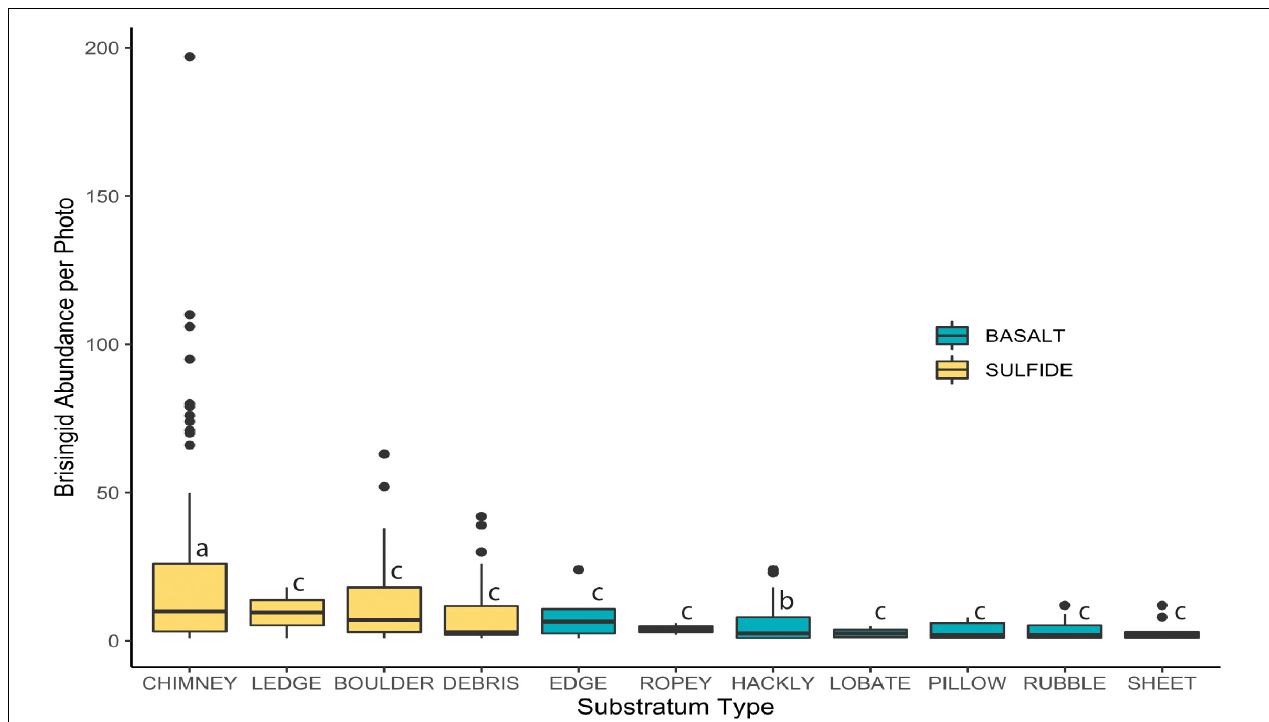
FIGURE 7 | Brisingid abundance per photo on sulfide and basalt, ordered by median values. Horizontal line: median; filled area: 25th through 75th percentiles; whiskers: maximum and minimum values; symbols: outliers (i.e., more than 1.5 × the length of the box from either end). Letters indicate significant differences ( p ≤